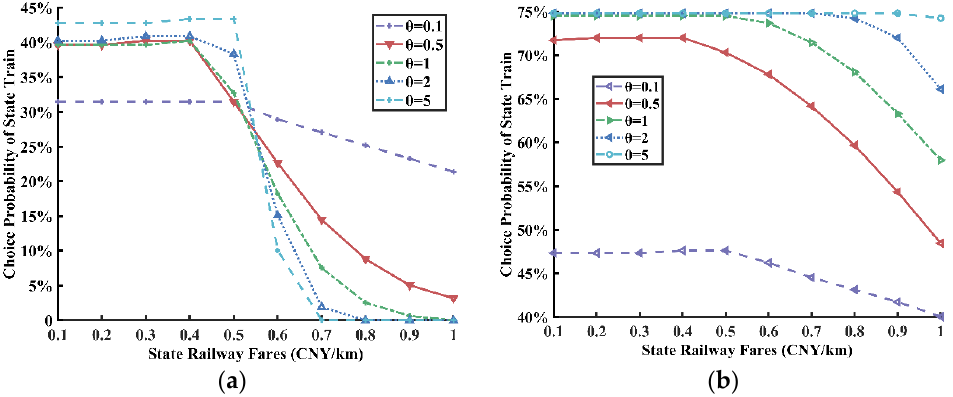
Figure 13. Sensitivity analysis of state railway fares to state train choice probability of suburban passengers at station No. 5. ( a ) Current train No. 7 (Local). ( b ) Current train No. 8 (State).